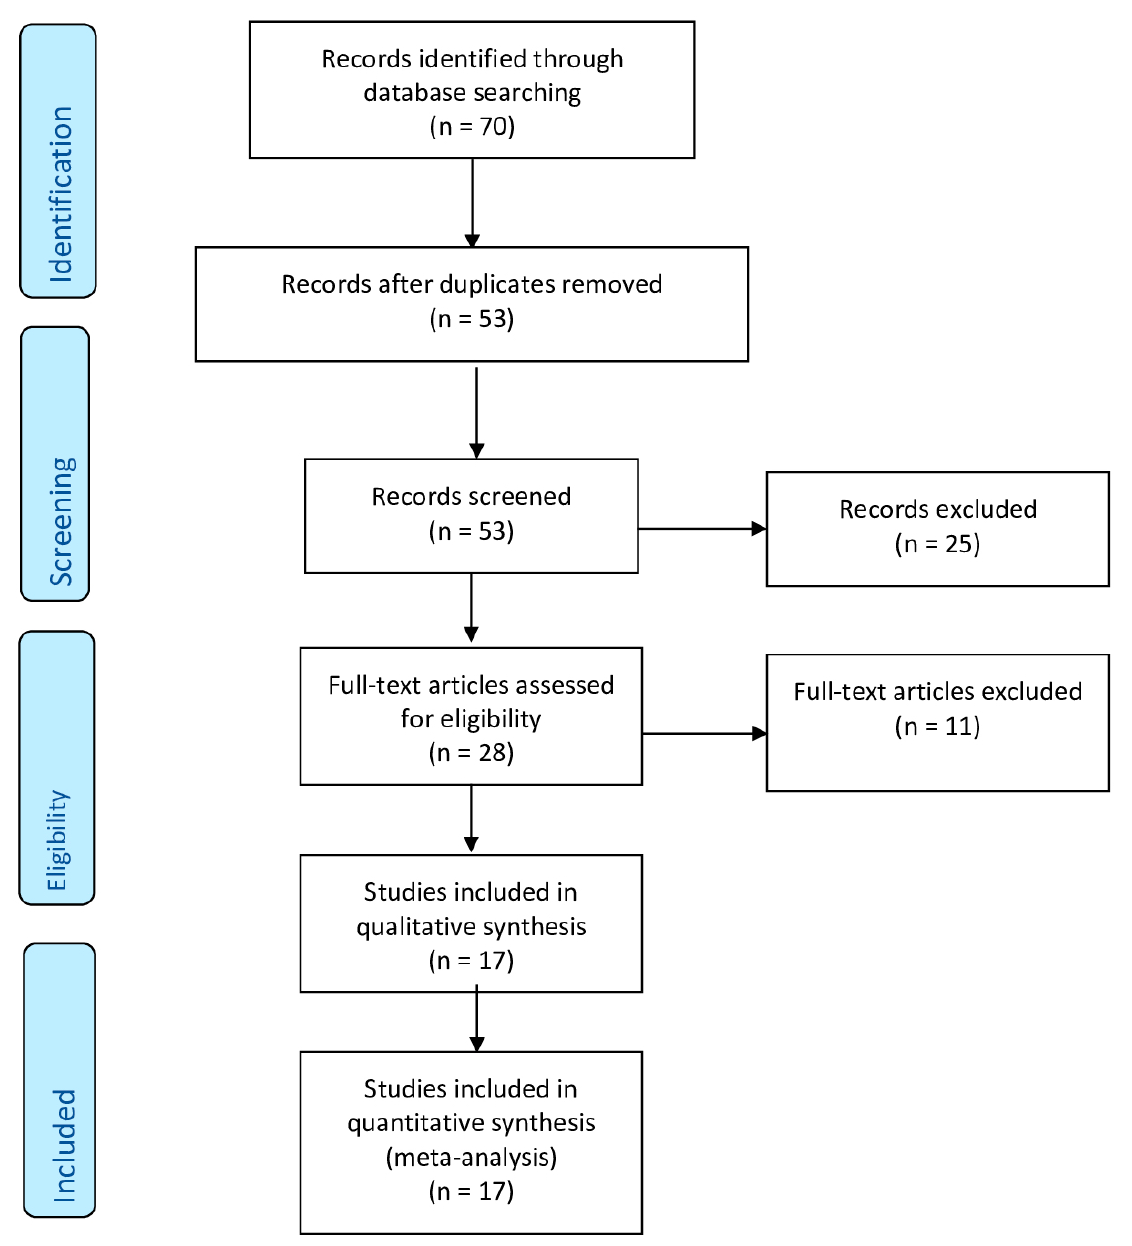
Figure 1. PRISMA flow diagram. Table 2. Monoclonal antibodies used in the included studies.